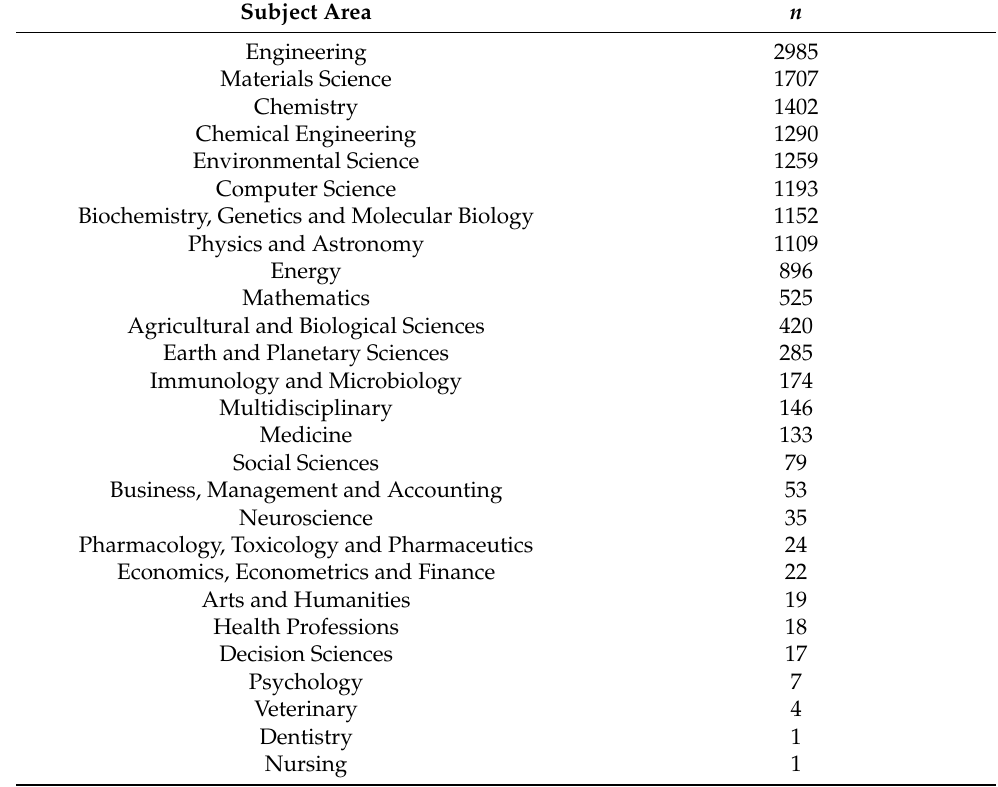
Figure A1. The enlarged view of the 3 clusters ( A – C ) from the term-map analysis. Table A1. Number of publications ( n ) per the complete list of subject categories as different disciplines (see Table 2).